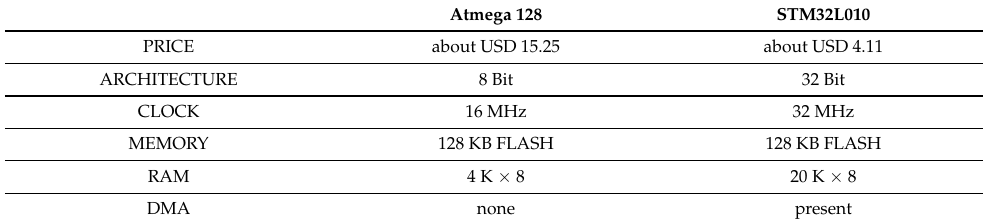
Table 2. Comparison of parameters of Atmega128 and